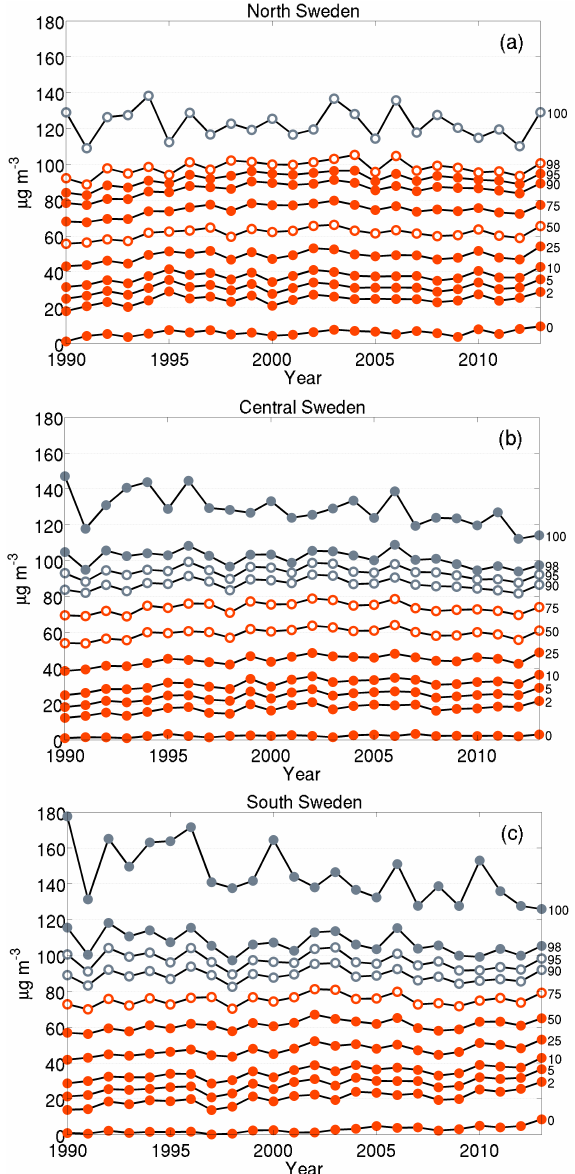
Figure 8. Temporal variation of annual percentiles of near-surface ozone concentrations averaged over the three regions: north (a) , central (b) and south (c) of Sweden (see Fig. 3). The line marked 0 is the zero-percentiles (lowest hourly mean near-surface ozone concentration of the year), 100 represents 100th percentile (high- est hourly mean near-surface ozone concentration of the year), 50 is the 50th percentile (i.e., annual median of the hourly mean near- surface ozone concentration). The sign of the corresponding linear trend (see Table S3, including a statistical analysis of the trend) of each percentile is indicated by color: a negative linear trend over 1990–2013 is indicated by grey symbols; a positive trend by orange symbols. Statistically significant trends ( p ≤ 0 . 05) are indicated by thick lines. Results from the LONGTERM